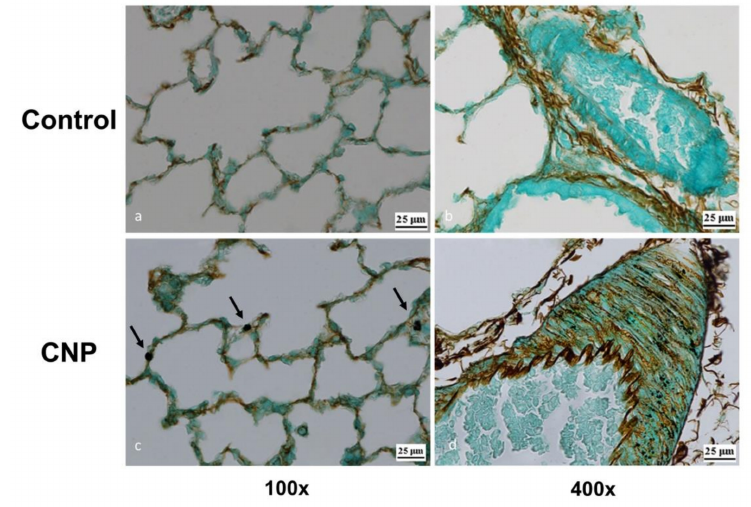
Figure 15. Rat lungs 2 h after administration of CNP suspension (16 mg / kg). Grocott’s staining technique revealed: ( a ) the alveoli of the lung of control rat (400 × ); ( b ) control rat lung artery (400 ×